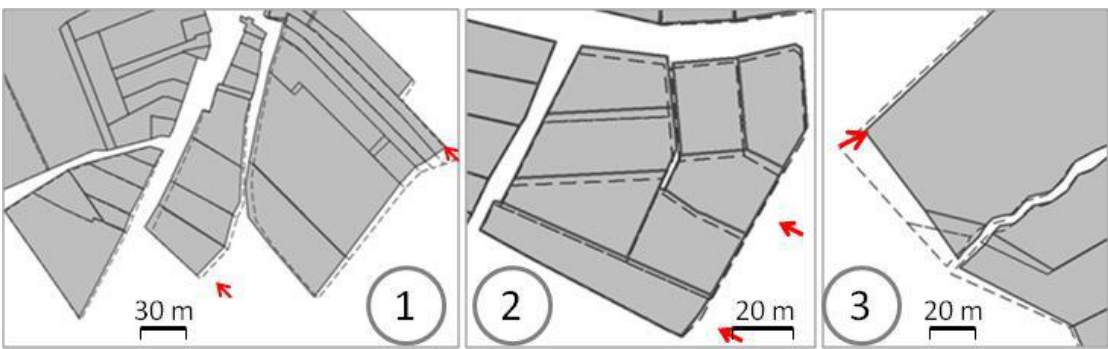
Figure 16. Conflated parcels (dashed lines for initial data) extracted from the Figure 14 (area with small distortion, the arrows show some matching vectors) ( 1 ) polygon shapes are well preserved, ( 2 ) small spaces between parcels are preserved, ( 3 ) even curve spaces due to rivers are preserved.